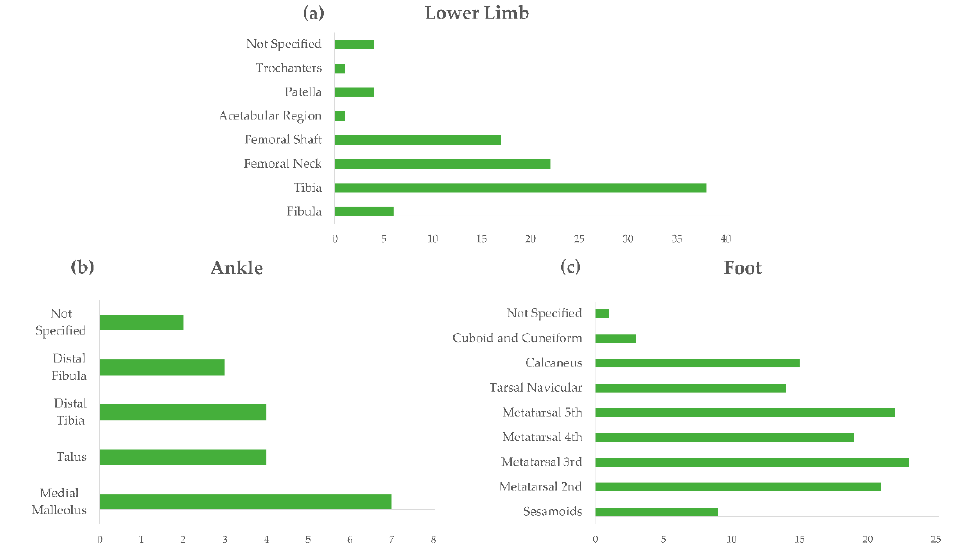
Figure 5. Reviewed articles regarding location of stress fractures in lower limb ( a ), ankle ( b ), and foot ( c ).